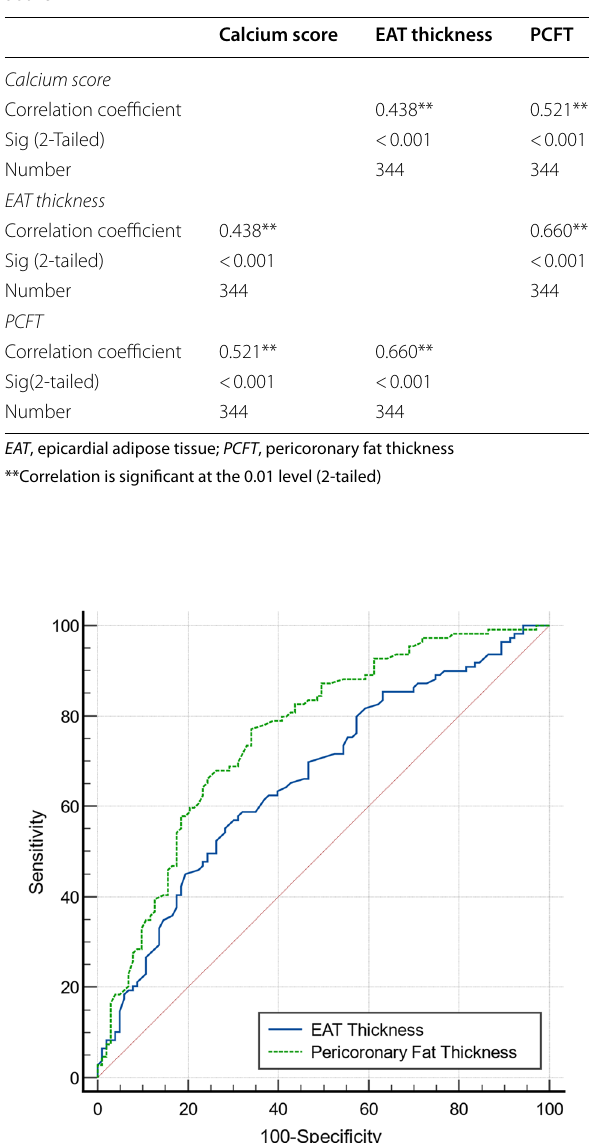
Table 1 The relationship between clinical characteristics and EAT thickness and PCFT